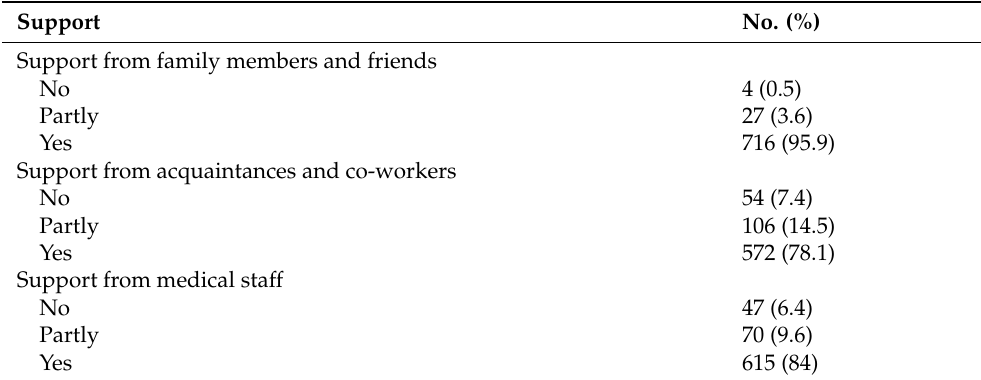
Table 3. Support providers for SARS-CoV-2 notified cases in the first pandemic wave.